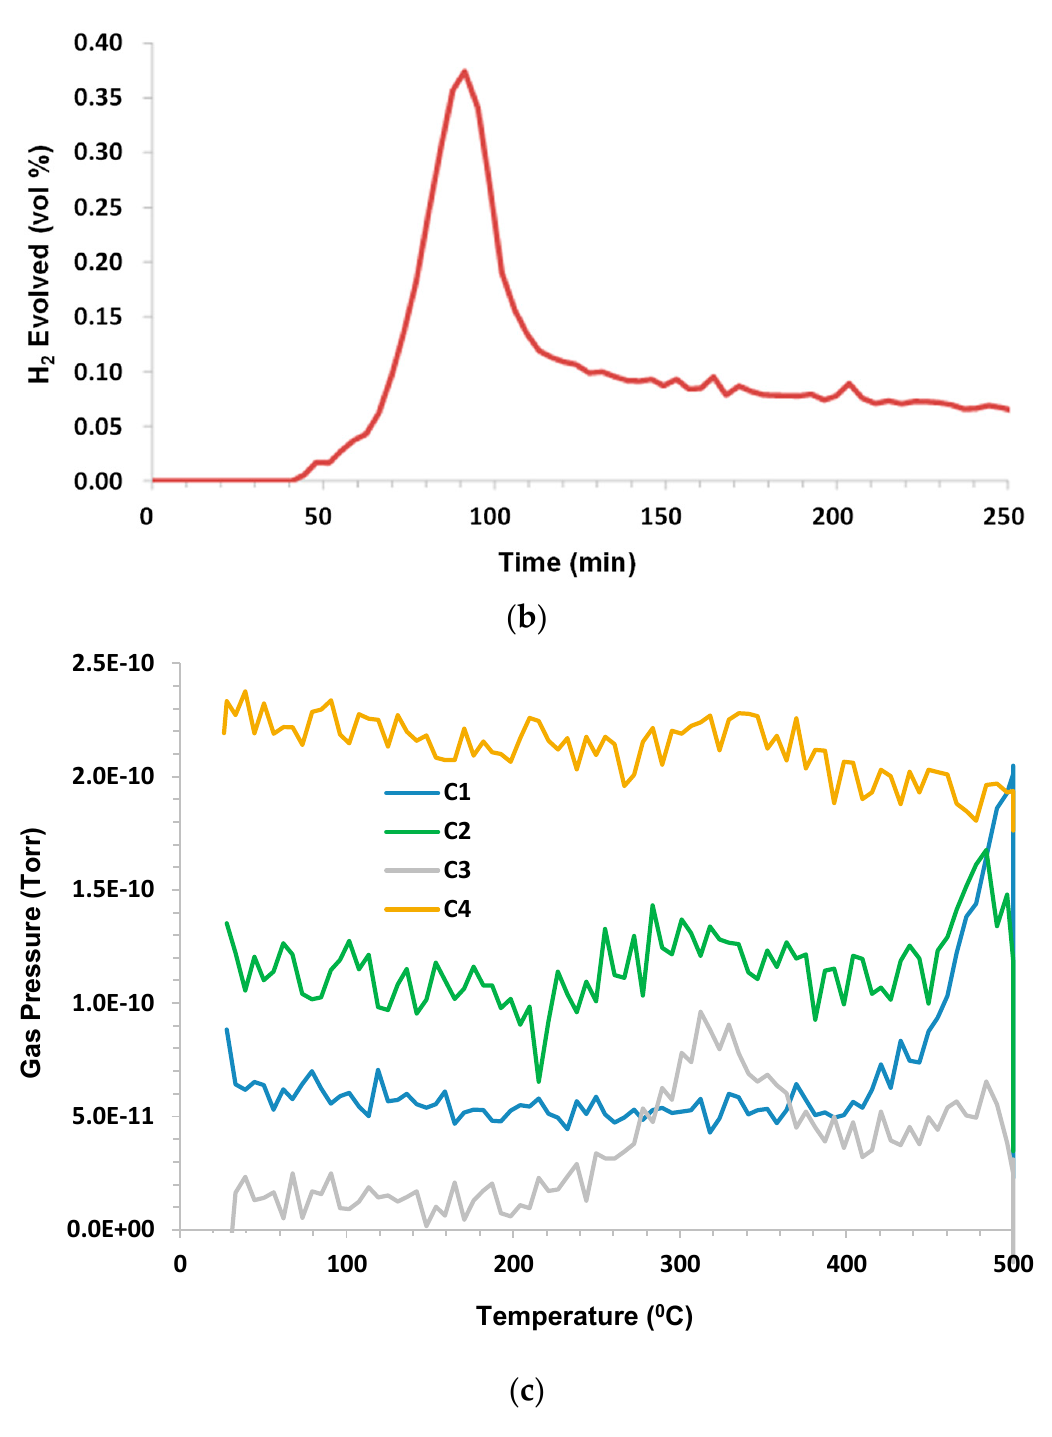
Figure 5. Cha tt anooga shale (1) in humid CO 2 . ( a ) Gas pressure and temperature as a function of time. ( b ) H 2 evolved (vol%) as a function of time. ( c ) Gas pressure as a function of temperature.